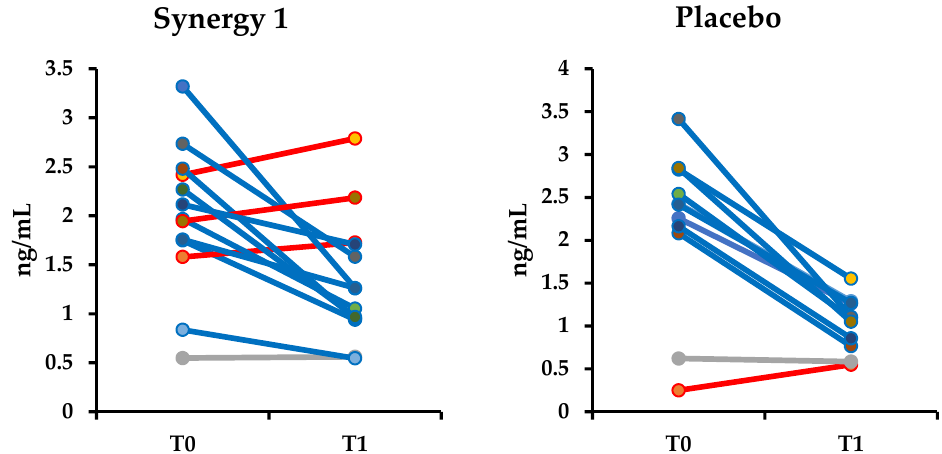
Figure 4. Changes in intestinal fatty acid-binding protein (iFABP) concentrations in the individual subjects from Synergy 1 and placebo group. Increases in the concentration are marked in red.